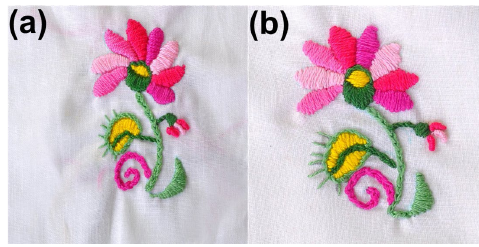
Figure 7. Digital photos of cotton hand embroidery threads ( a ) before coating and ( b ) after coating, displaying no change in the color or flexibility of threads.